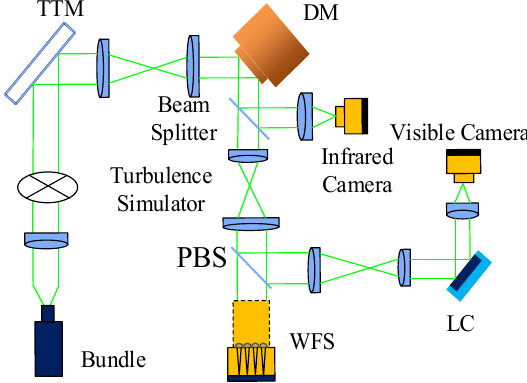
Figure 1. Block diagram of the LC–DM AO